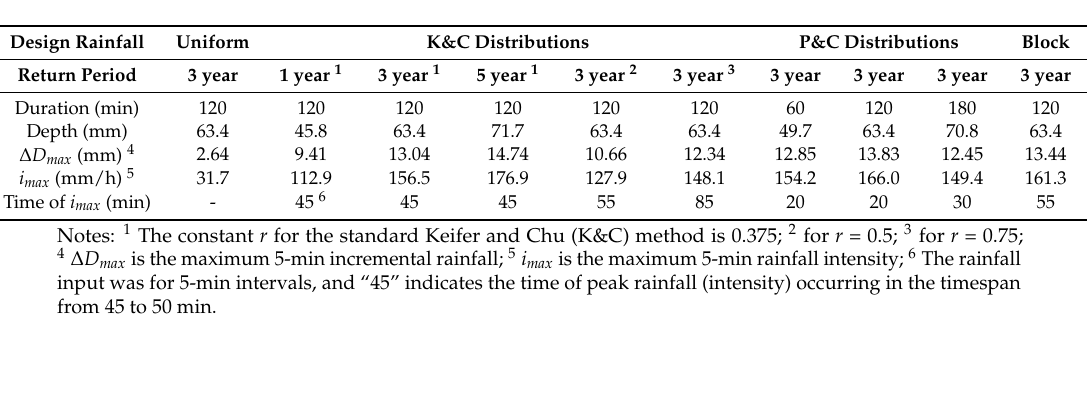
Table 2. Summary information for design rainfall distributions used in model simulations.